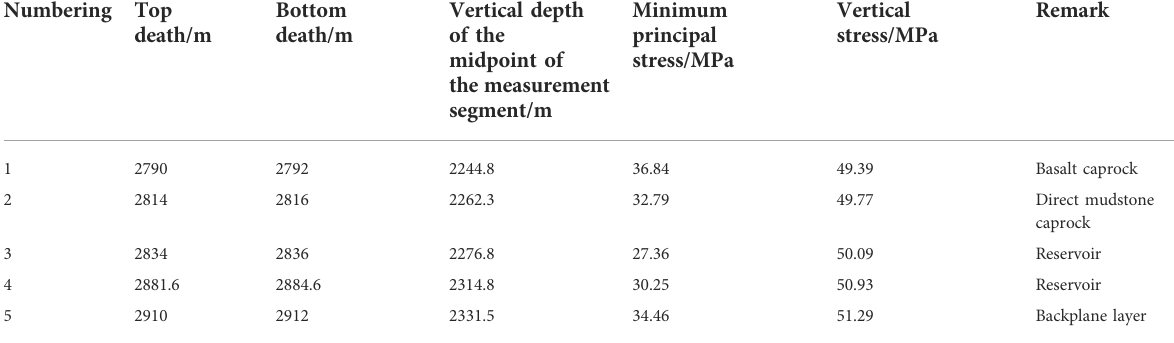
TABLE 3 Summary of the measurement results of in situ stress caused by hydraulic fracturing in Well C1.